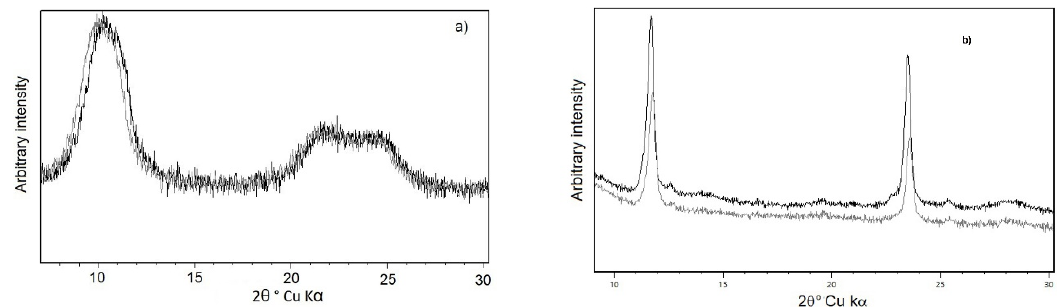
Figure 5. PXRD for ( a ) the NiAl nitrate LDH before (dark grey) and after (light grey) pollutant removal from the wastewater and ( b ) the MgAl carbonate LDH before (dark grey) and after (light grey) pollutant removal from the wastewater.